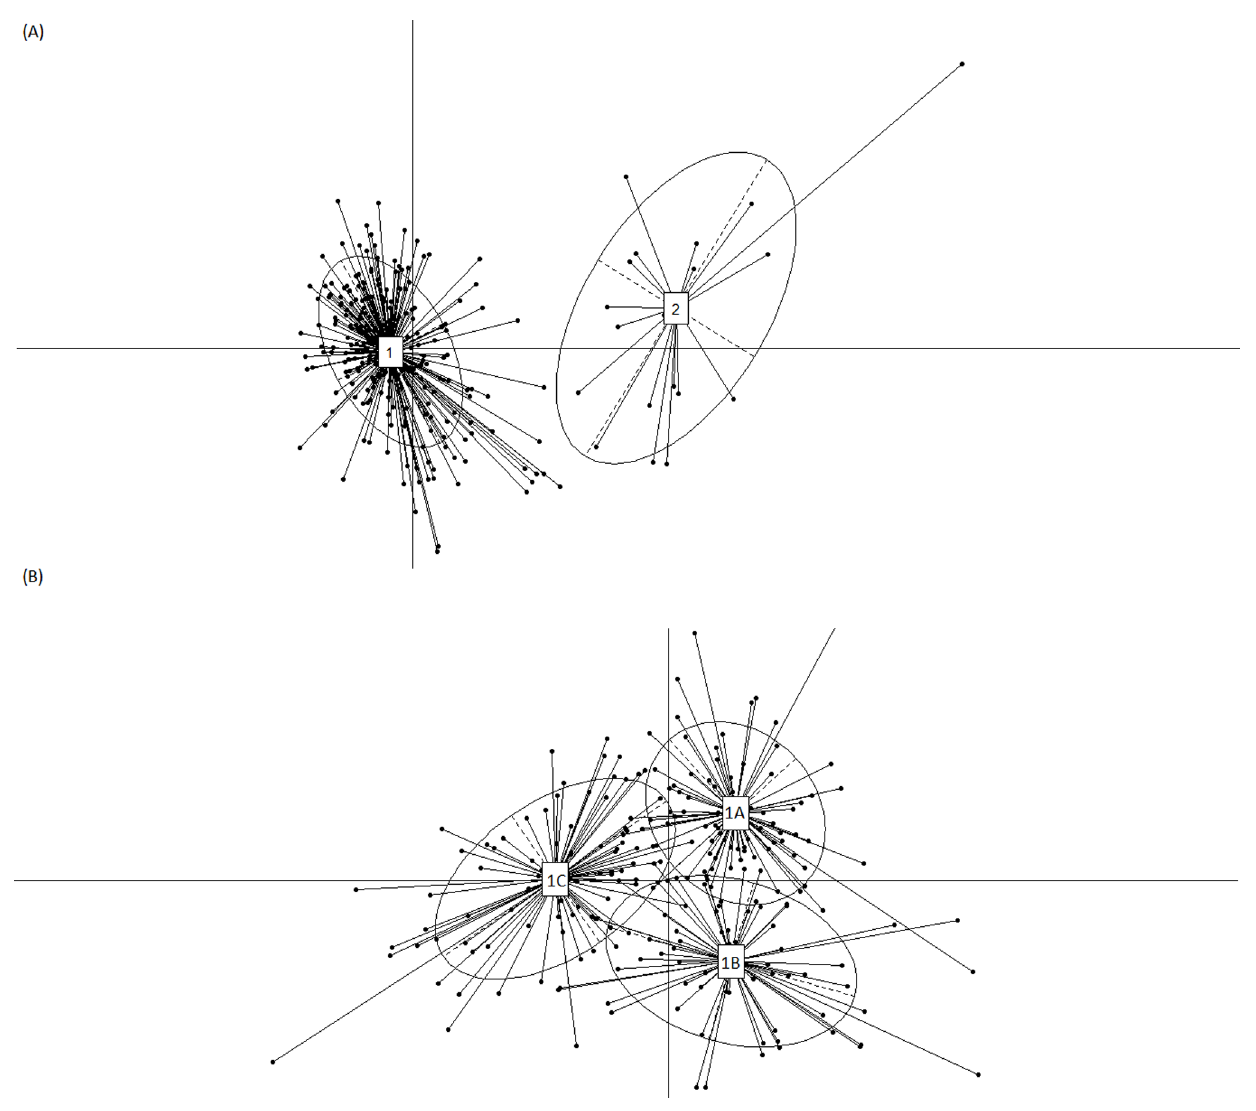
Figure 7. Distinct clustering of gut microbiomes based on similarities in the abundance patterns of genes conferring resistance to various antibiotics. Each cluster represents a ‘Resistotype’. (A) Resistotype 2 (observed specifically in Chinese individuals) and Resistotype 1 (containing gut microbiomes from individuals from all geographies). (B) Resistotype 1 resolved into three sub-clusters (Resistotypes 1A, 1B and 1C).